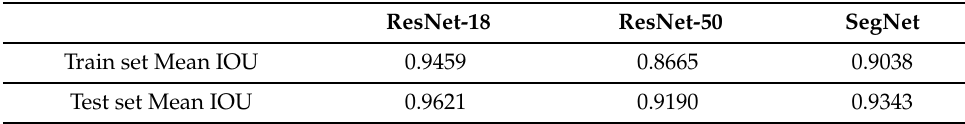
Table 8. Comparison of IOU results of the trained models.